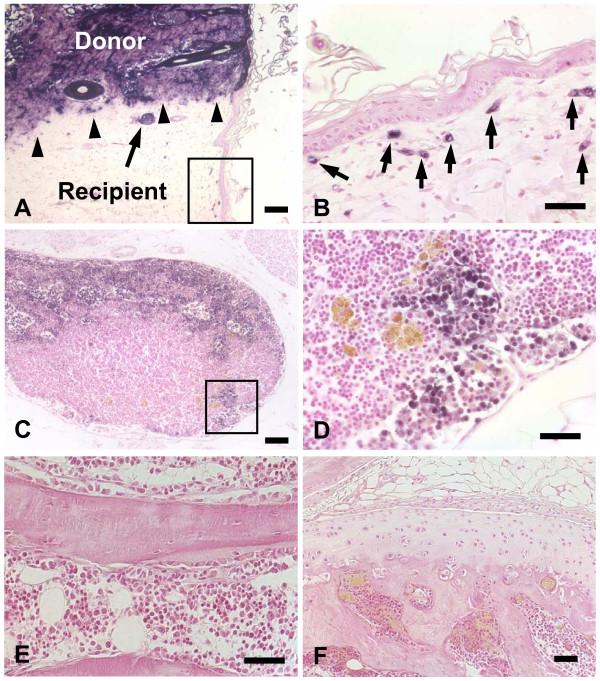
Utility of neonatally tolerized rats for cell tracking. To test whether neonatal exposure of wild-type rats to transgenic cells results in long-lasting tolerance to the marker gene, skin from hPLAP-tg donor was grafted into a neonatally tolerized, 4-month-old F344 wild-type rat. Four weeks post-transplantation, the skin graft from the transgenic donor (upper part of the section) shows strong expression of hPLAP in all cells (A). The border between transgenic donor tissue and wild-type recipient tissue is sharply delineated (arrowheads). A sebaceous gland (arrow in A), and a few capillaries (arrows in B) of transgenic donor origin are found in the surrounding wild-type skin. Keratinocytes do not cross the sharp border between wild-type and transgenic epidermis. Fig. 5B is a high power view of the frame shown in (A). When hPLAP-tg BMC were intravenously injected in neonatally tolerized F344 WT recipients, transgenic donor leukocytes are clearly present in an abdominal lymph node, 2 months post-injection (C-D). Fig. 5D is a high power view of the frame shown in (C). However, hPLAP-tg BMC injected intravenously in neonatally tolerized F344 WT recipients do not home to bone, bone marrow, or cartilage (E-F). Five-μm-thick paraffin or MMA sections of ethanol-fixed skin biopsy (A-B), abdominal lymph node (C-D), tibia (E), and knee joint (F) stained for hPLAP activity after heat pretreatment and counterstained with nuclear fast red. Bar = 100 μm (A, C) or 50 μm (B, D-F).